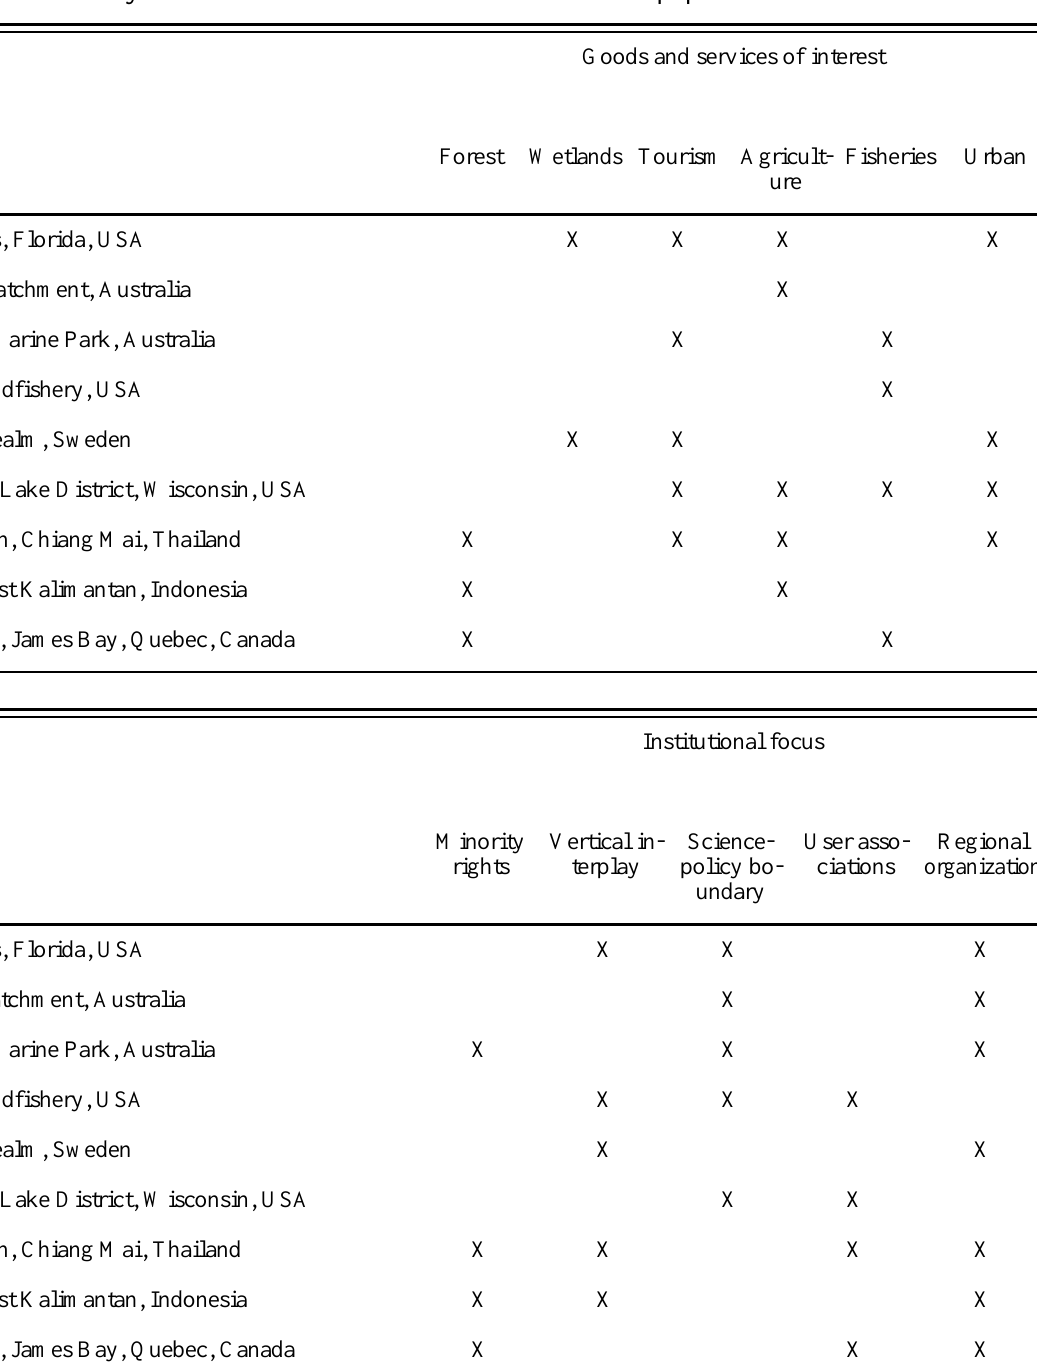
Table 1 . A concise summary of the main case studies referred to in this